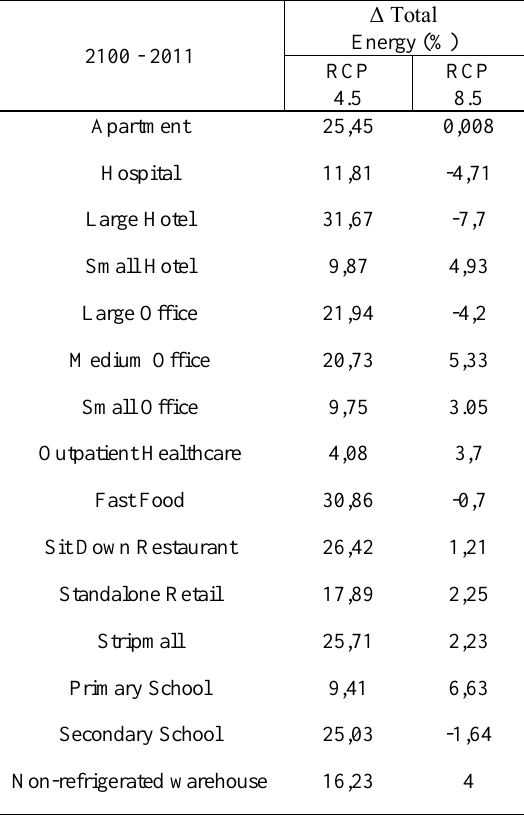
Table 1. Change in annual HVAC energy demand for 15 different types of buildings, RCP 4.5 and RCP